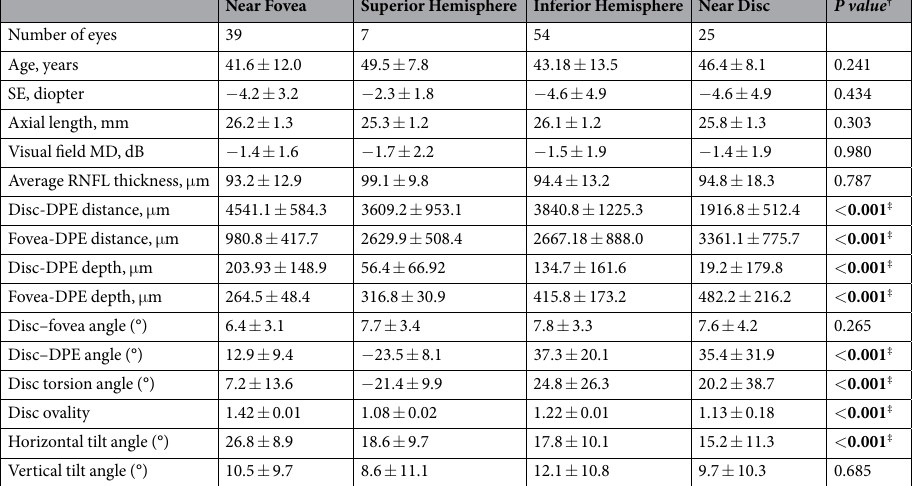
Table 4. Comparison of posterior pole characteristics according to the different locations of the DPE in myopic patients * . SE: spherical equivalent; MD: mean deviation of perimetry; RNFL: retinal nerve fiber layer; DPE: deepest point of the eyeball. * Data are presented as mean ± standard deviation unless otherwise indicated. † Kruskal–Wallis test for continuous variables between the four groups. ‡ Statistically significant values ( P < 0.05) are shown in